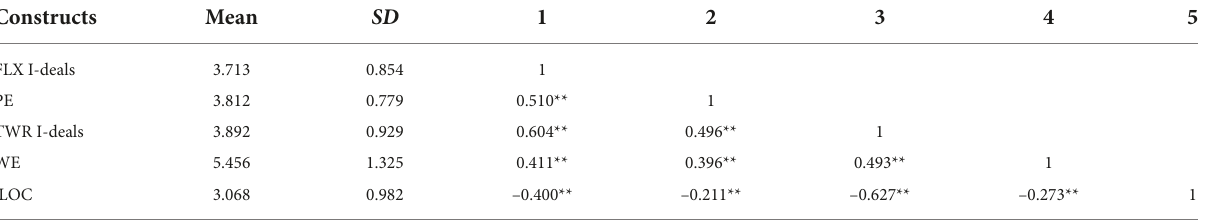
TABLE 2 Descriptive statistics and correlation analysis ( N = 324).